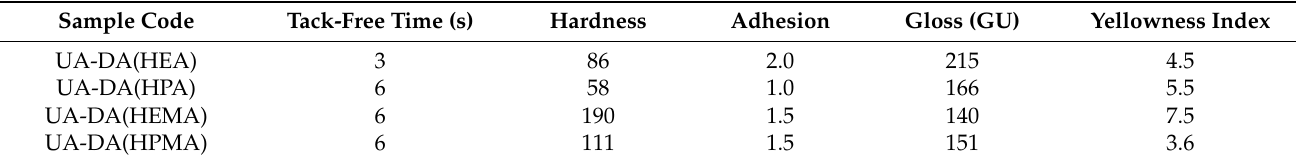
Table 3. Properties of the cured